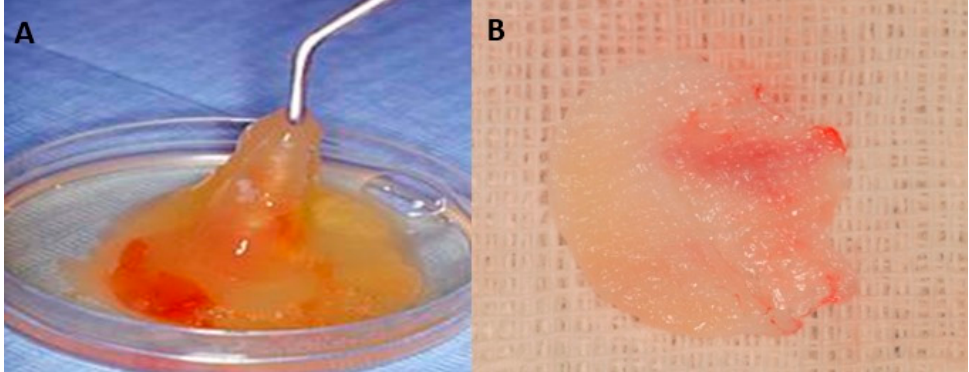
Figure 11. ( A ) PRF preparation; ( B ) PRF autologous membrane.